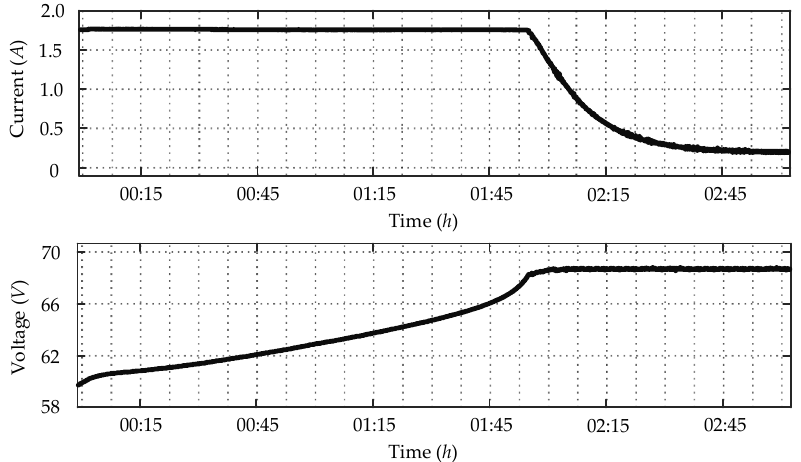
Figure 15. Experimental results for the batteries’ charge process, including constant current charge mode and constant voltage charge mode.